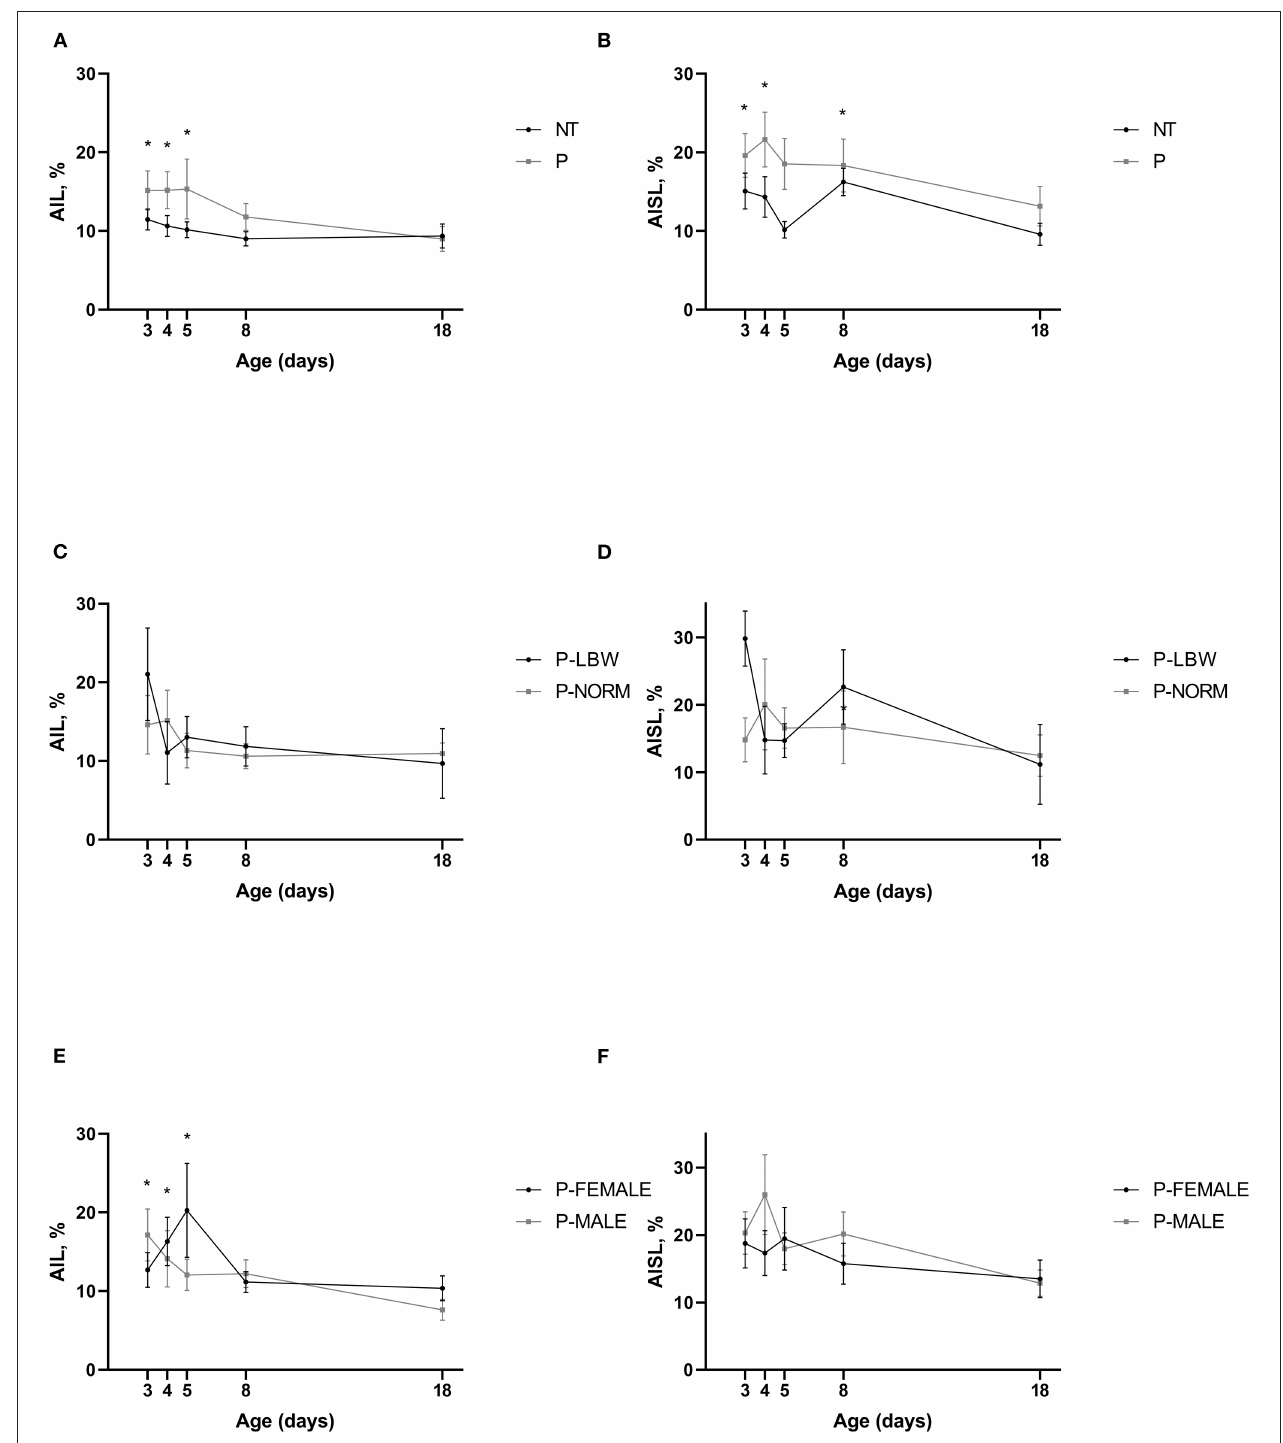
FIGURE 4 | Gait symmetry. All values are mean SE. Asymmetry index stride length (AIL) according to postnatal age and (A) condition (P: preterm, gray; T: term, ± black), (B) birth weight (normal birth weight (P-NORM); low birth weight (P-LBW), and (C) sex (female: P-FEMALE; male: P-MALE). AIL is higher in P than in T piglets. Mean values indicated with * differ significantly from d18. Asymmetry index step length (AISL) according to postnatal age and (D) condition (P: preterm, gray; T: term, black), (E) birth weight (normal birth weight (P-NORM); low birth weight (P-LBW), and (F) sex (female: P-FEMALE; male: P-MALE). AISL is higher in P than in T piglets (front leg). Mean values indicated with * differ significantly from